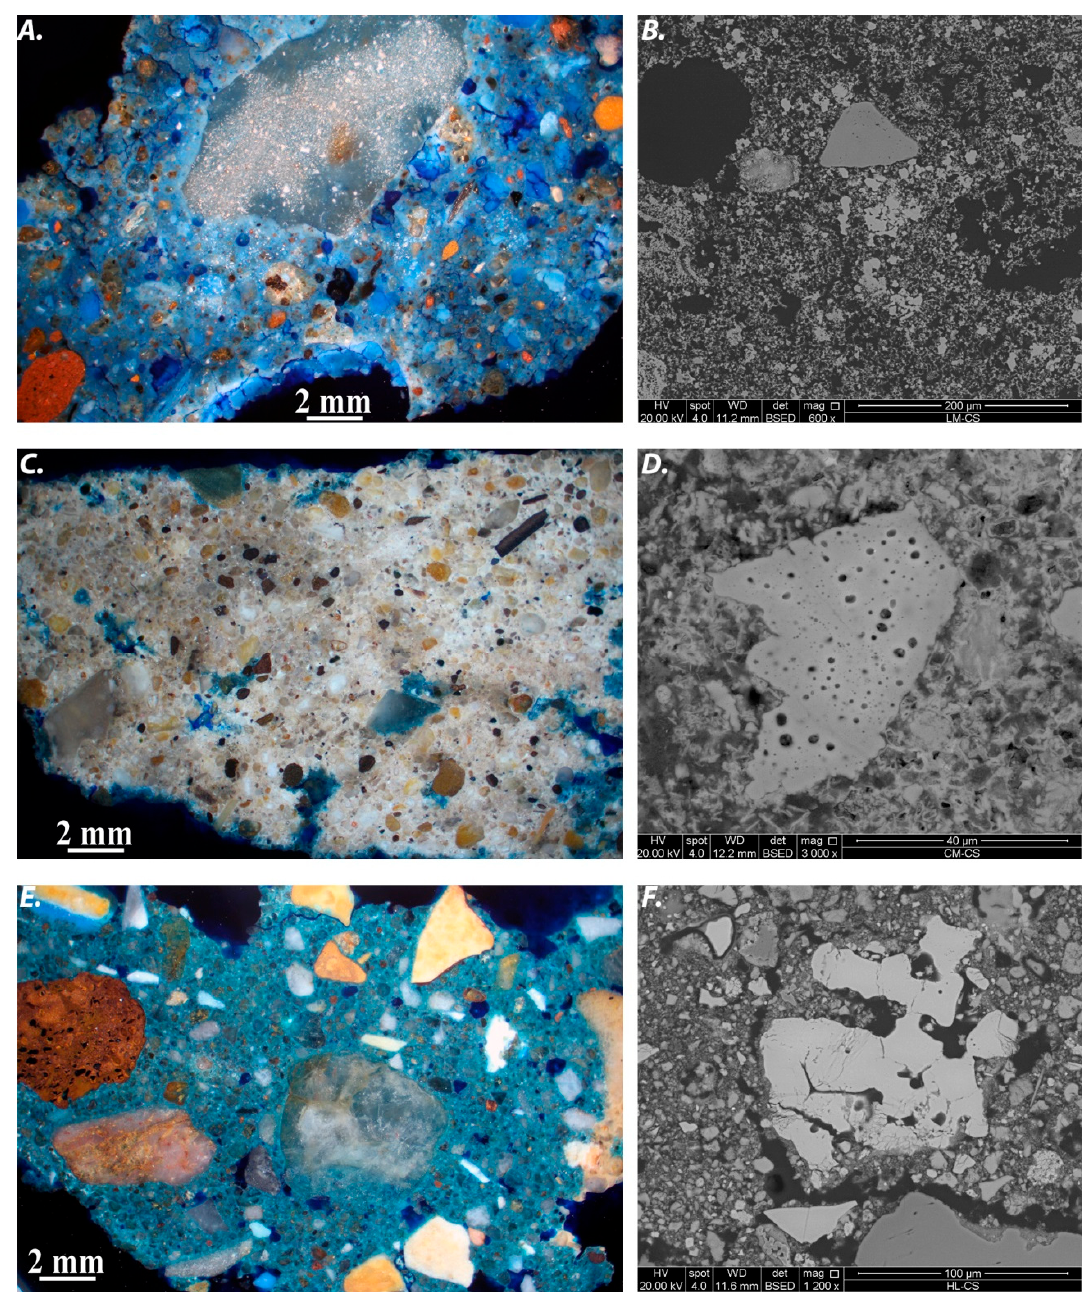
Figure 3. Optical (left) and scanning electron microscopy (SEM, right) micrographs of mortars collected from Wardrobe Tower during 2017 conservation work. ( A ) Original bedding mortar (BM), showing ( B ) porous lime binder with partly recrystallized calcite. ( C ) Probable early 19th-century pointing mortar (HM3), with ( D ) residual calcite indicating low temperature of calcination. ( E ) Probable late 20th-century pointing mortar, with ( F ) large crystal of rankinite. Note differing scale bars for SEM images.